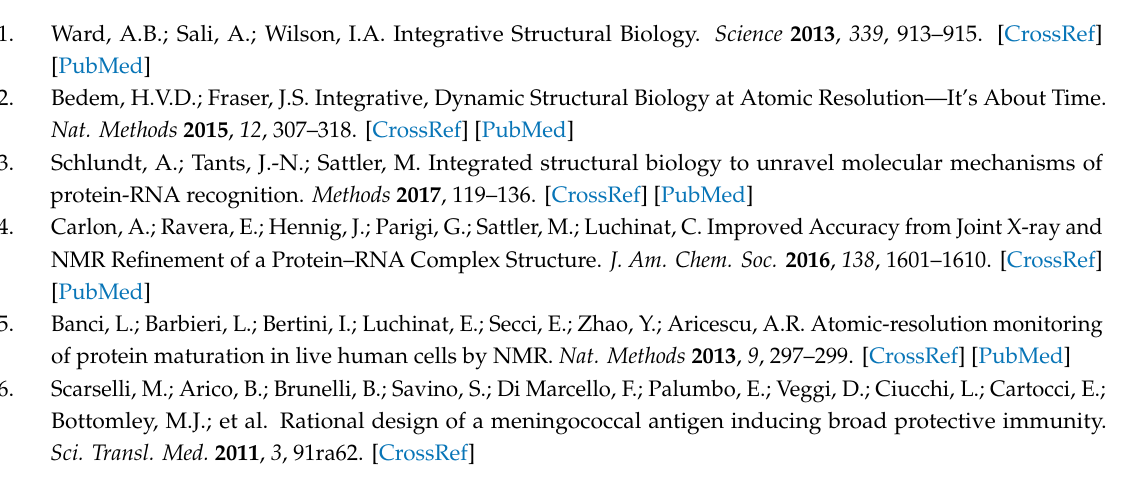
Figure S1: Cryo-EM micrograph and 2D classes of free ANSII (right) and ANSII PEGylated with PEG 5000 (left), Figure S2: Fit of the experimental RDC values collected in the presence of filamentous phages Pf1 (used as alignment medium) to the structural model with the lowest haddock-score calculated implementing either (A) only experimental SSNMR restraints (Qfactor 0.29), or (B) experimental SSNMR restraints together with RDCs (Qfactor 0.14) in HADDOCK 2.2, Table S1: Tensor parameters of the RDCs collected in the presence of filamentous phages Pf1 to the calculated structural models with the lowest haddock-scores. Table S2: HADDOCK statistics evaluated on the 200 water refined models of ANSII implementing either only experimental SSNMR restraints or experimental SSNMR restraints together with RDCs. The reported data are related to the best four structural models of the two main clusters with the lowest